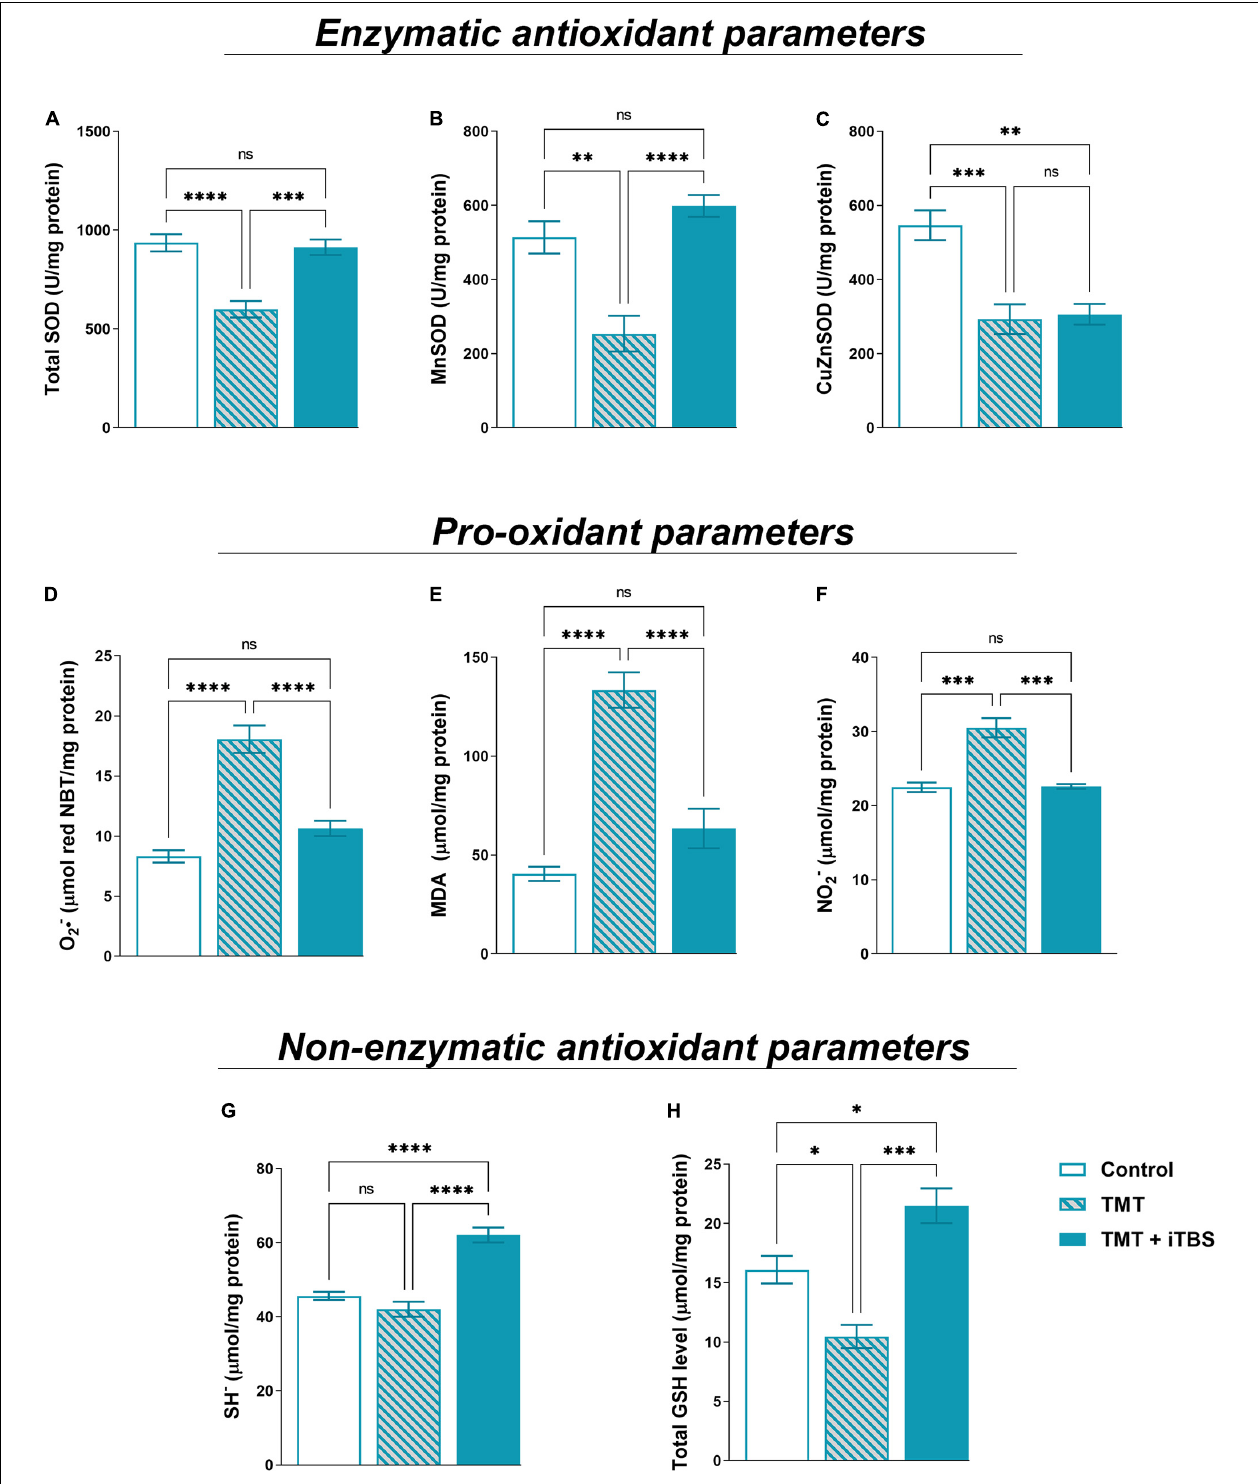
FIGURE 6 | Effect of iTBS treatment on TMT-induced oxidative stress. Spectrophotometric analysis of antioxidant parameters: (A) total SOD, (B) MnSOD, (C) CuZnSOD, and pro-oxidant parameters: (D) O 2 •− , (E) MDA (malondialdehyde), (F) NO 2 − and non-enzymatic antioxidant parameters- (G) SH − and (H) total GSH level, measured in hippocampal protein homogenates ( n = 4–5 animals/group). Bars represent mean activity, expressed as U/mg protein (A–C) , µ mol/mg protein (D–H) , ± SEM. Results of post hoc Tukey’s test and significance are shown inside graphs: ∗ p < 0.05, ∗∗ p < 0.01, ∗∗∗ p < 0.001, ∗∗∗∗ p < 0.0001, ns, no